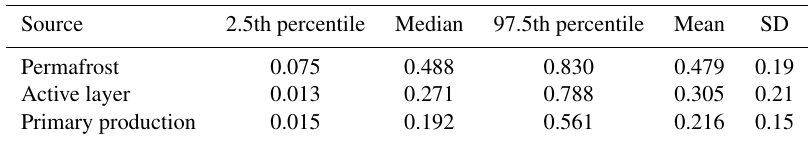
Table 6. Mean relative contribution of three identified sources (source fractions) to the integrated signal at the catchment outlet, using δ 13 C DOC for the primary-production endmember.